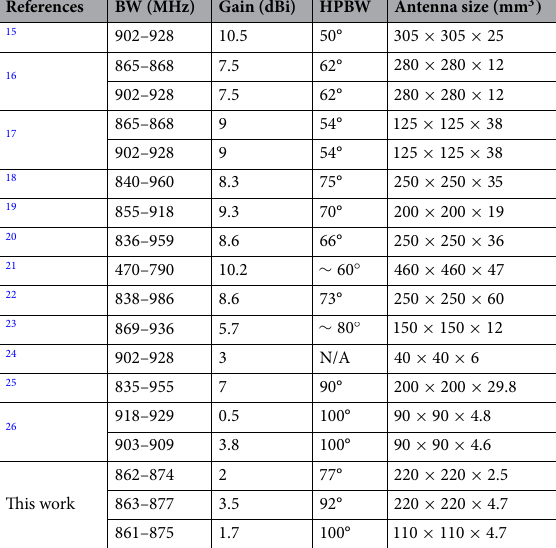
Table 2. State-of-the-art design of RFID reader antennas operating in the UHF